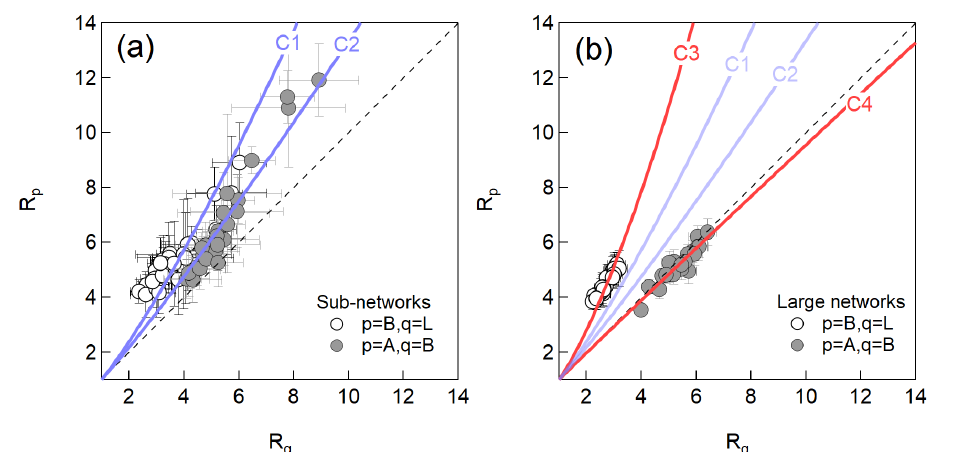
Figure 10. Comparison between R p and R q for ( a ) sub-networks and ( b ) large networks. Curves C1 to C4 are fitting functions given by Equation (7). The fitting exponent is given in the text. Referential horizontal and vertical error bands were also